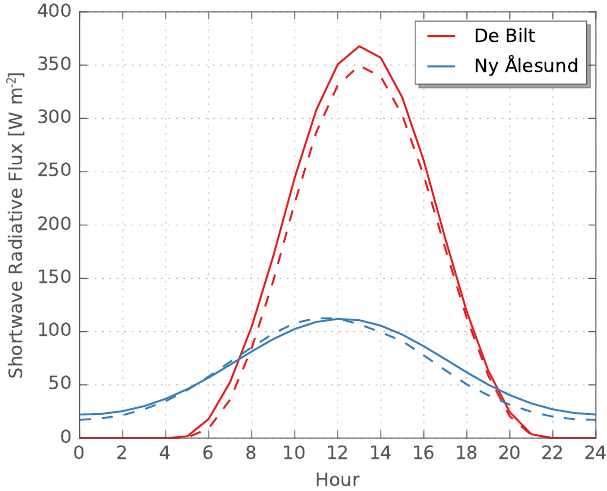
Figure 12. Long-term averages of diurnal courses of observed (dashed) and disaggregated (solid) shortwave radiation. Disaggre- gation is based on daily recordings of sunshine duration (R2